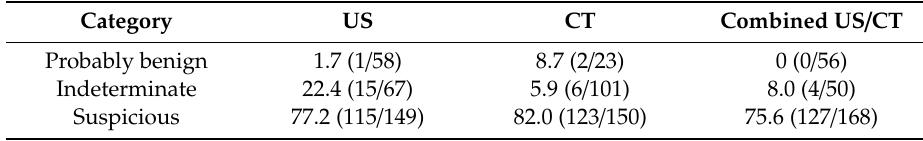
Table 2. Malignancy risks of the US, CT, and combined US / CT categories. Table 3. Malignancy risks of the combined US/CT categories according to the US and CT categories. Unless otherwise indicated, data in parentheses are the number of LNs.